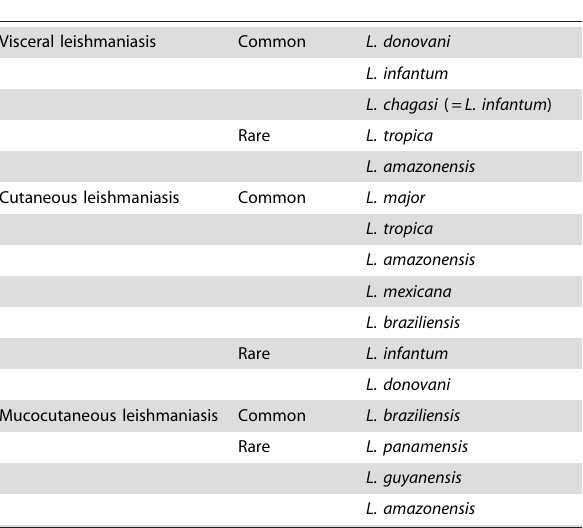
Table 1. Leishmania species and disease phenotype.